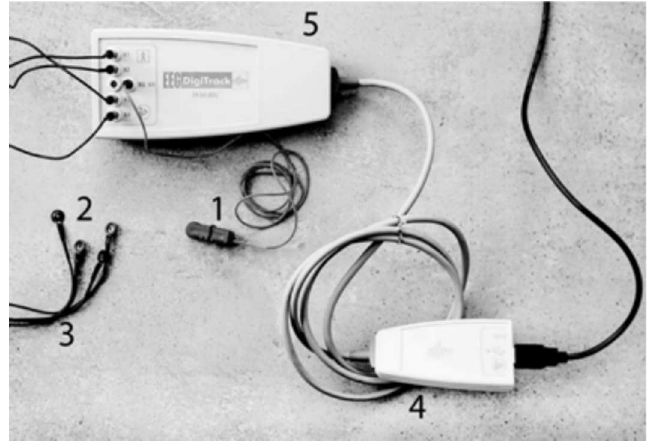
Figure 1. The measuring equipment: 1 – reference electrode, 2 – cup-shaped electrode, 3 – wiring, 4 – measurement interfaces, 5 – transducer for analyses/signal